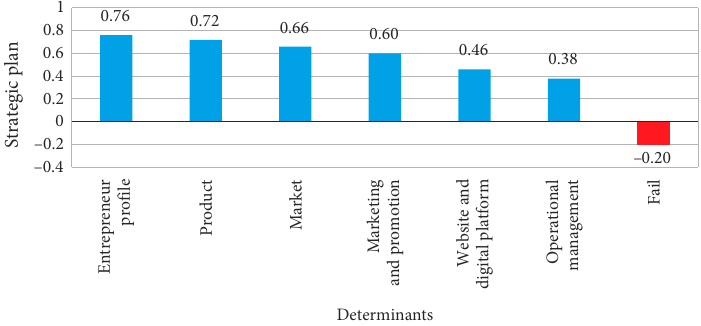
Figure 7. Impact on strategic plan of 1.00 variation in each